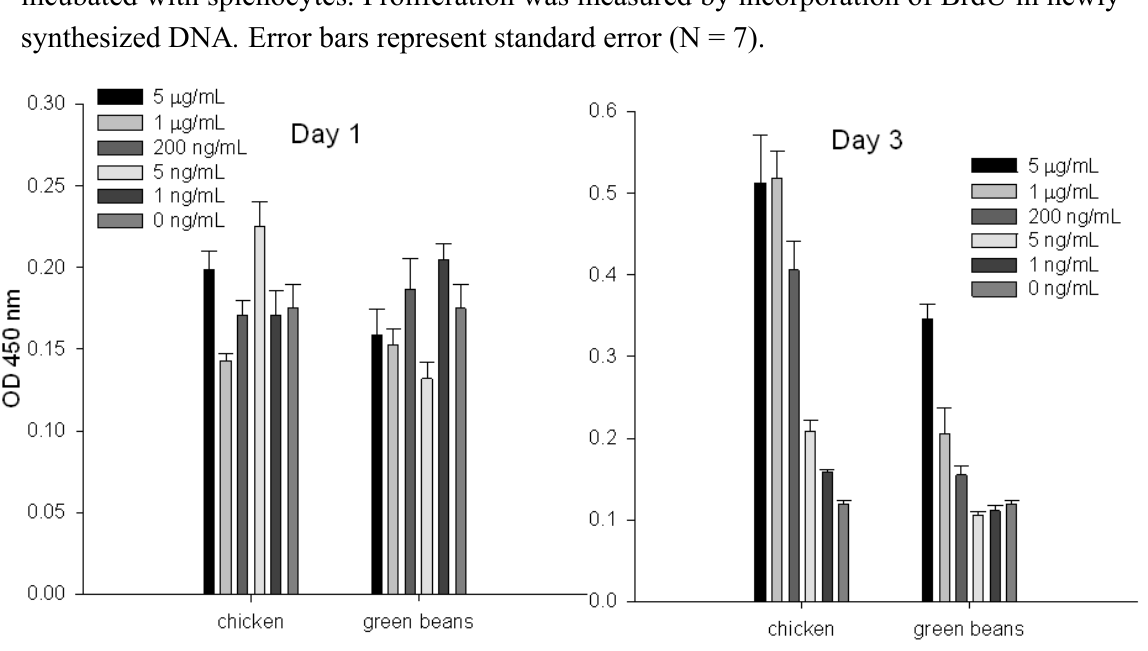
Figure 1. Detection and quantify of SEA in food using BrdU cell proliferation assay. Chicken and green beans were spiked with increasing concentrations of